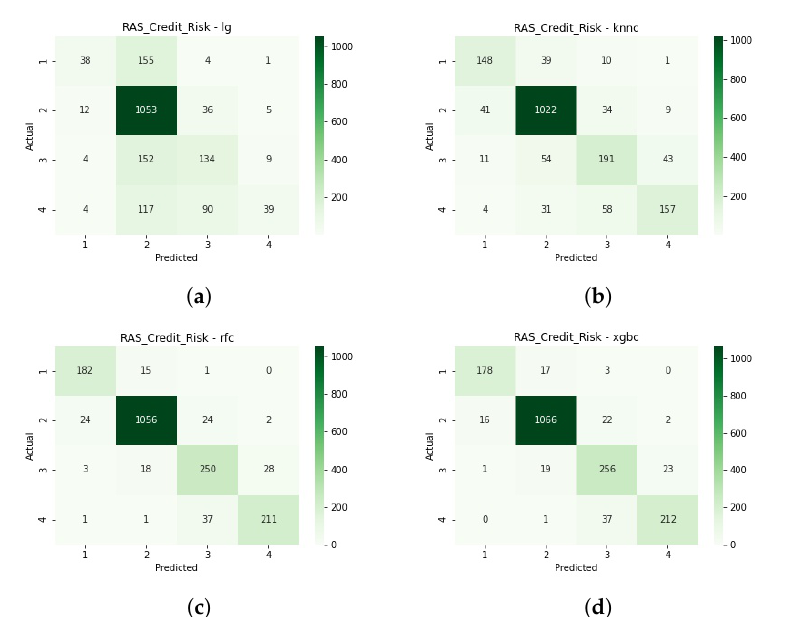
Figure A1. Credit risk: confusion matrices generated when evaluating the above-mentioned mod- els, using train-test split approach. ( a ) Logistic Regression. ( b ) k-Nearest Neighbours classifier. ( c ) Random Forest classifier. ( d ) Extreme Gradient Boosting classifier.